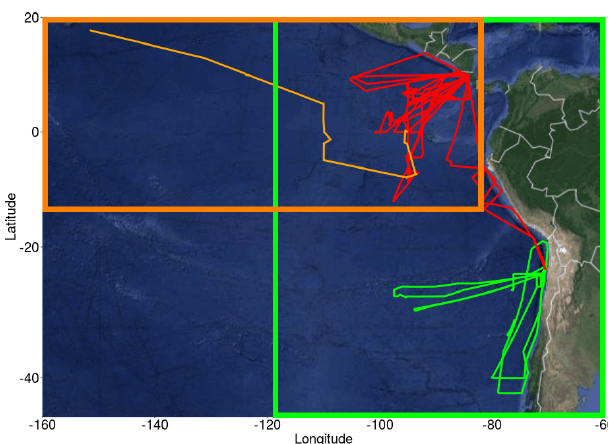
Figure 1. Flight and cruise tracks from the TORERO campaign (January–February 2012). Cruise track is represented by a light or- ange line. Flights are grouped by the following regions: tropical (red lines) and subtropical (green lines). Two different domains were de- fined: domain to evaluate the cruises (dark orange square) and do- main to evaluate aircrafts (green